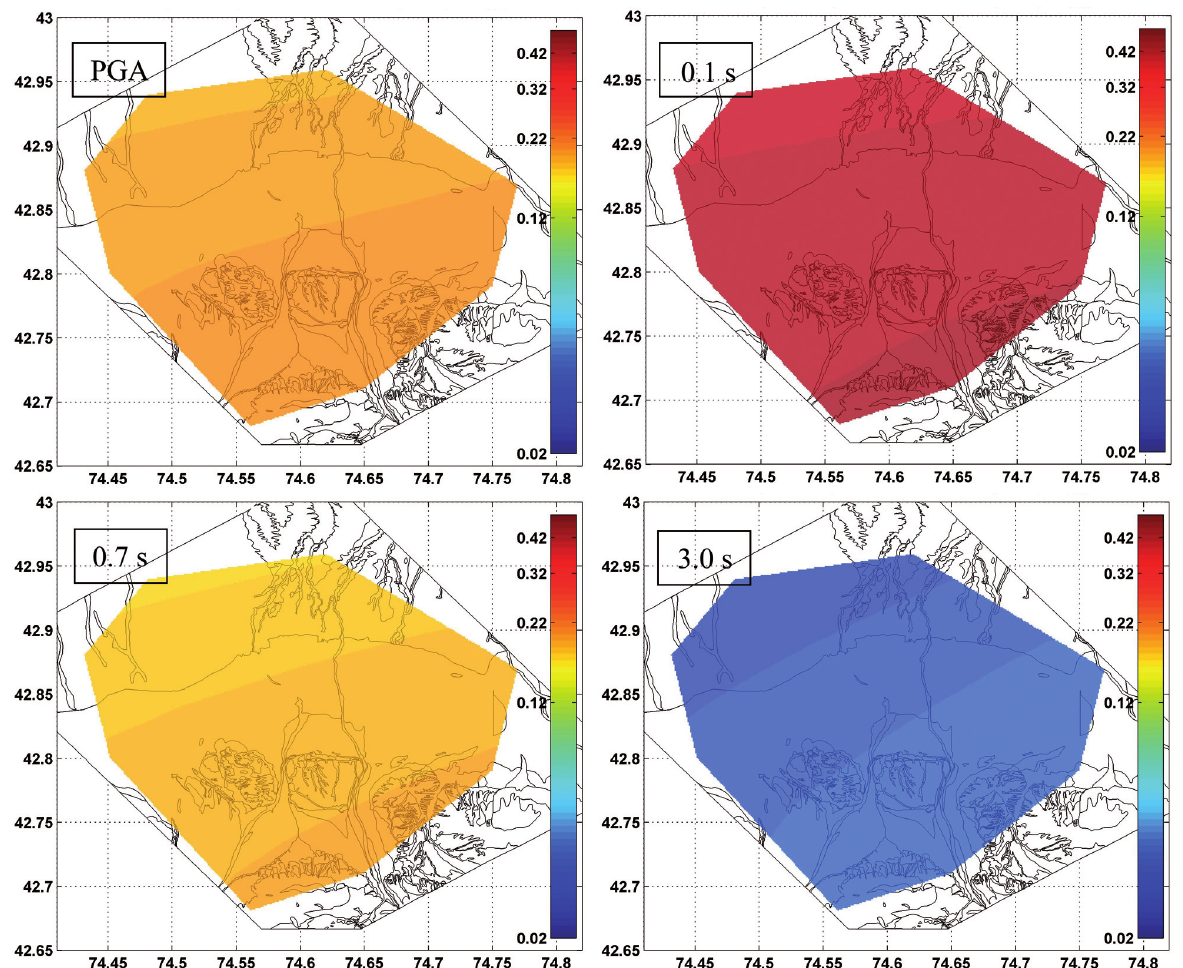
Figure 10. Seismic hazard in terms of 10% probability of exceedance in 50 years for rock-site conditions. The hazard is shown for PGA and spectral acceleration at different selected period in terms of g. For a detailed description of Geological map of the city in the background, see Figure 5.